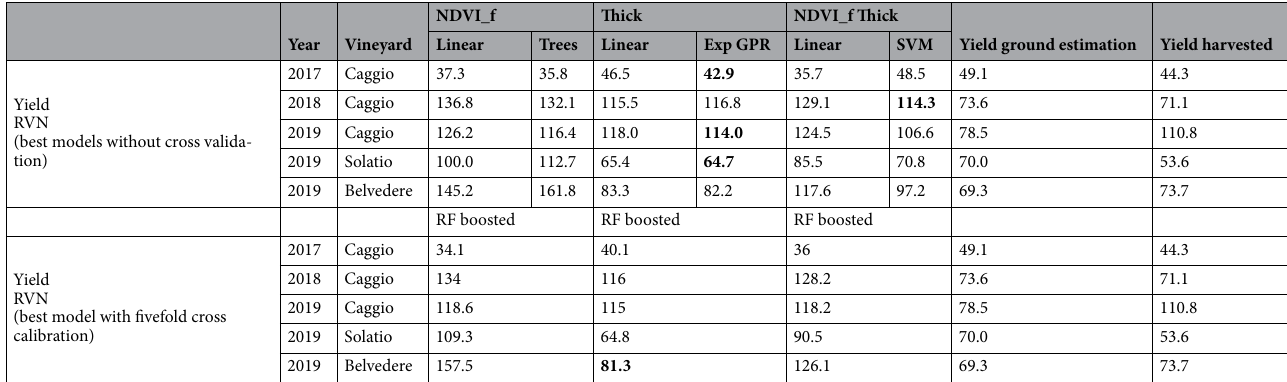
Table 7. Yield models’ output (quintals per hectare) related to real plant number without missing plants (Yield RVN) using NDVI filtered (NDVI_f), canopy thickness (Thick), NDVI filtered and canopy thickness (NDVI_f Thick) compared to yield ground estimation and yield harvested. The best resulting models are bold typed.